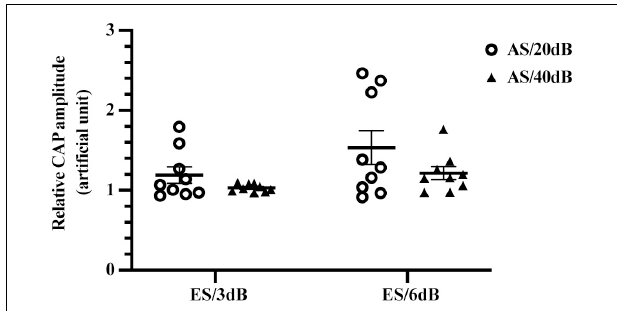
FIGURE 5 | Forward-ES interference in iECochG of AS with different intensities. There was no significant difference between relative CAP amplitudes of 20 and 40 dB 4 kHz AS with 3 or 6 dB 1 ms-forward ES, F (1,16) = 3.074, P = 0.0987. Meanwhile, 6 dB forward ES produced higher relative CAP amplitudes than 3 dB ES in iECochG of both AS/20 dB and AS/40 dB, F (1,16) = 6.675, P = 0.0200. Each plot means an animal data and the horizontal line means the mean across animals. AS/20 dB and AS/40 dB, acoustic stimulation equivalent to 20 and 40 dB above iECochG thresholds, respectively. Treated with two-way RM ANOVA.